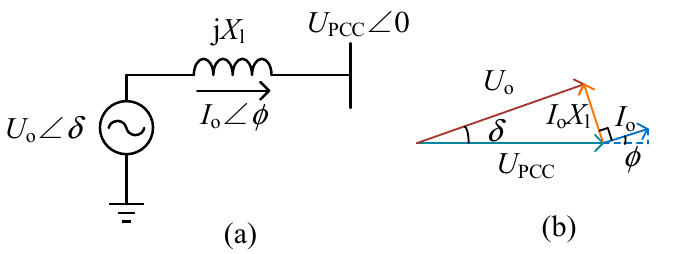
Figure 4. Inverter power transferring model: ( a ) line diagram of the inverter-PCC connection; ( b ) corresponding phase diagram.